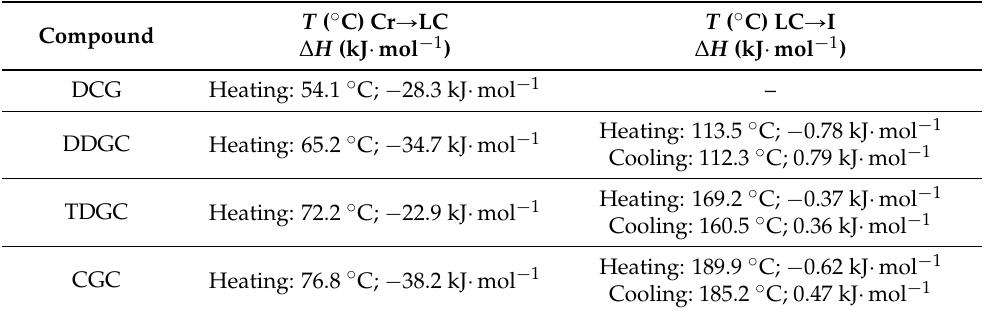
Table 1. Phases transition temperatures and enthalpies, as taken from the first heating and cooling cycle.